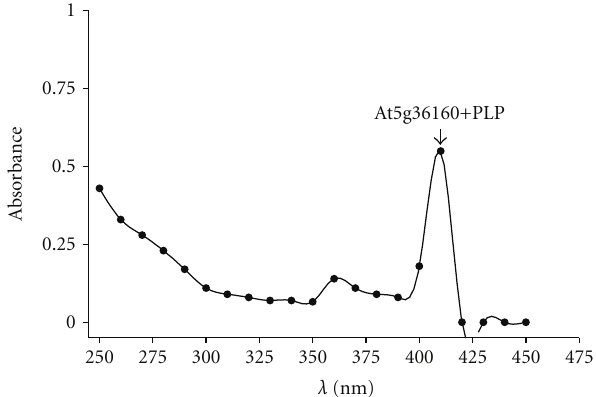
Figure 8: Absorption spectrum of At5g36160. UV-visible absorp- tion spectrum of the native purified recombinant enzyme (50 μ g) in 100mM HEPES-NaOH (pH 8.2). The PLP peak representing the PLP form of the enzyme is highlighted with an arrow.